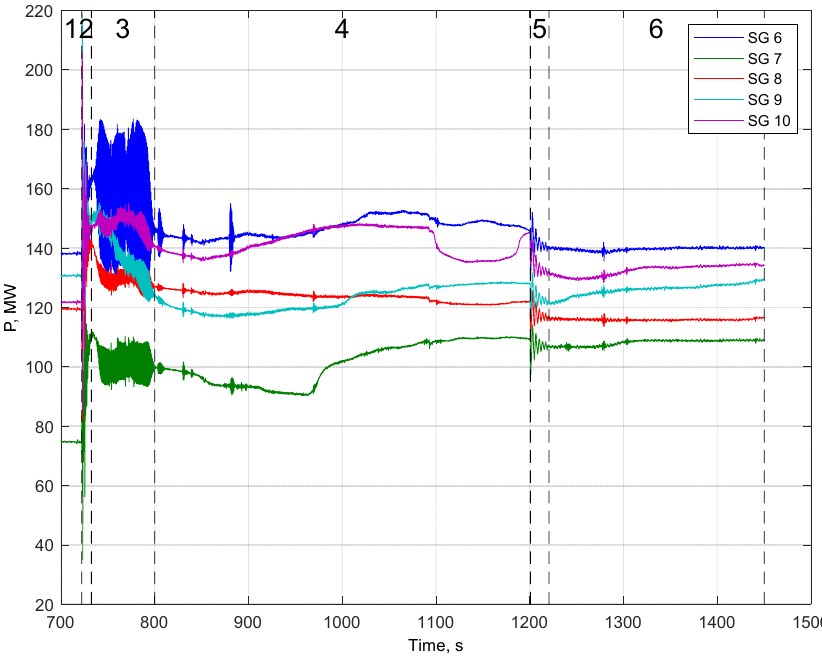
Figure 8. Active power signals.